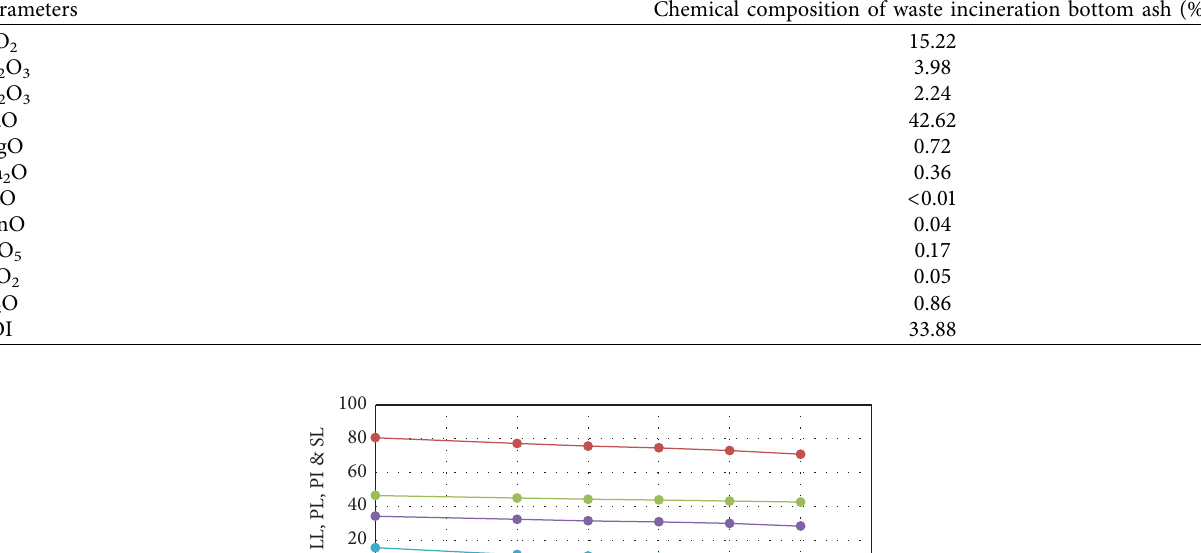
Table 3: Chemical composition of waste incineration bottom